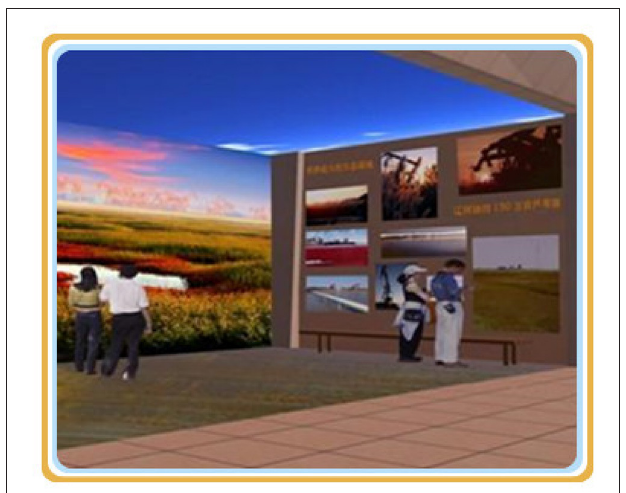
FIGURE 9 | Virtual tourism products